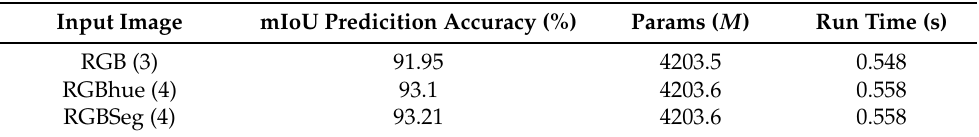
Table 5. mIoU prediction accuracy for different input channels.